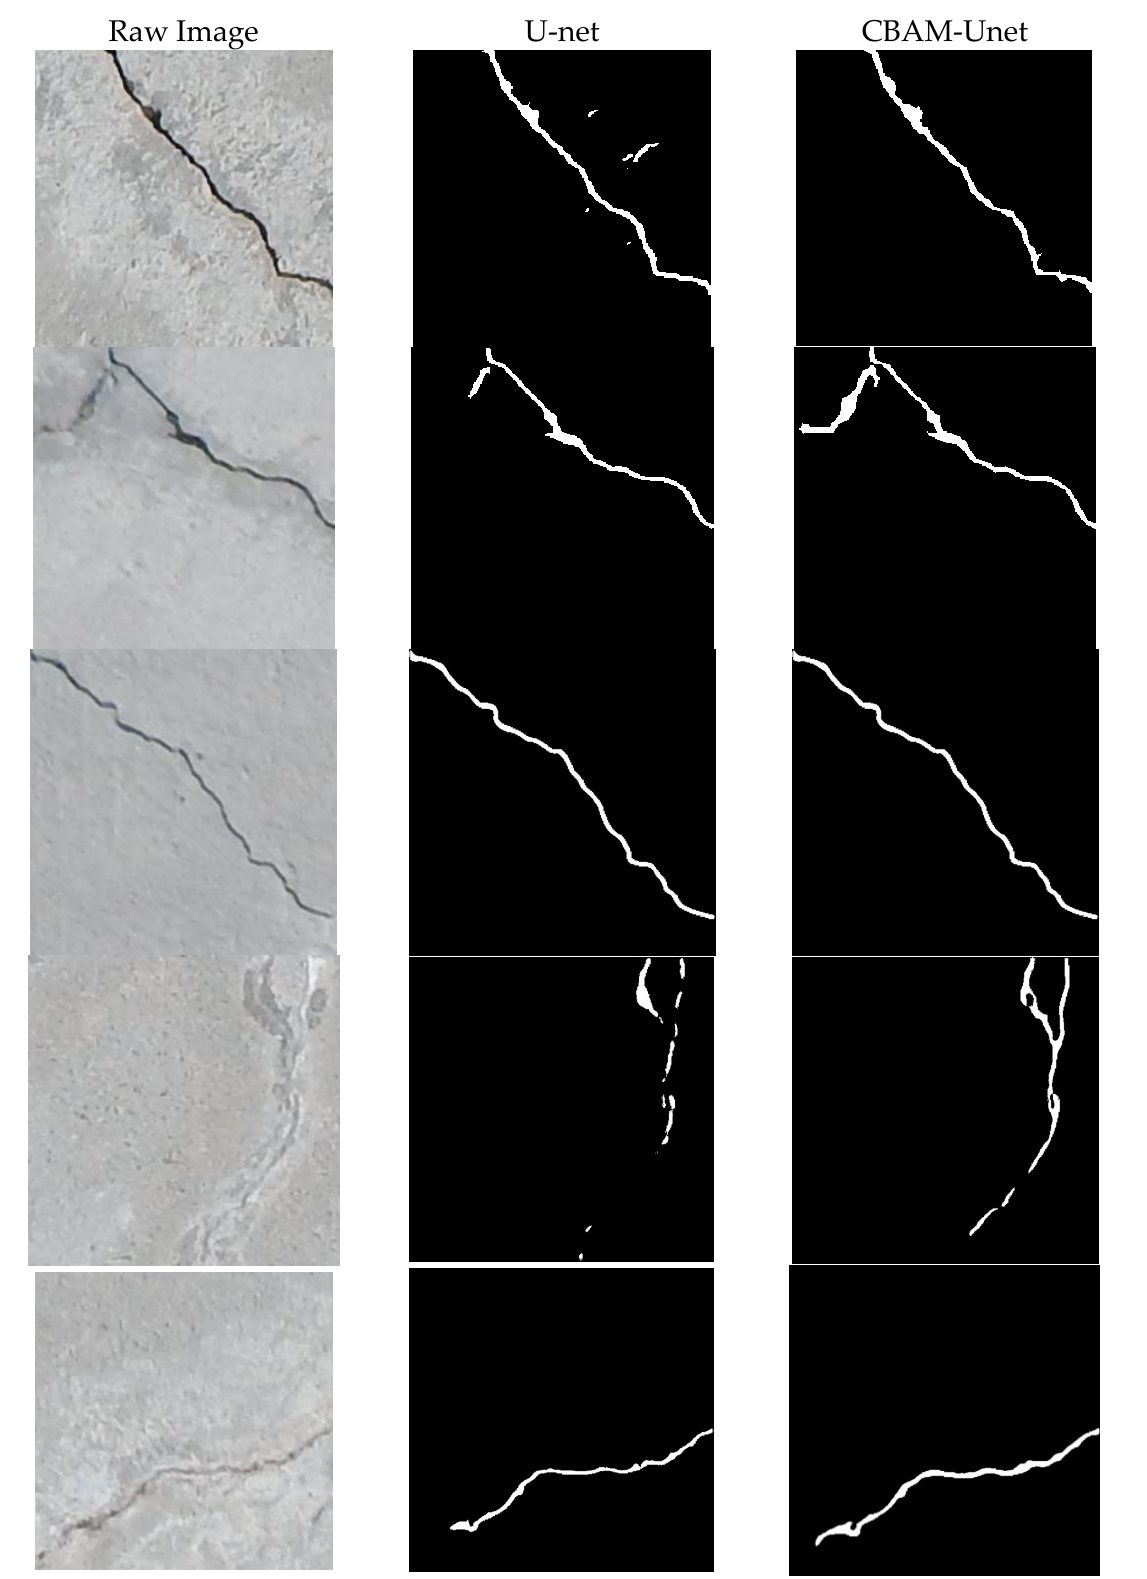
Figure 13. Results of the two methods under ideal conditions.